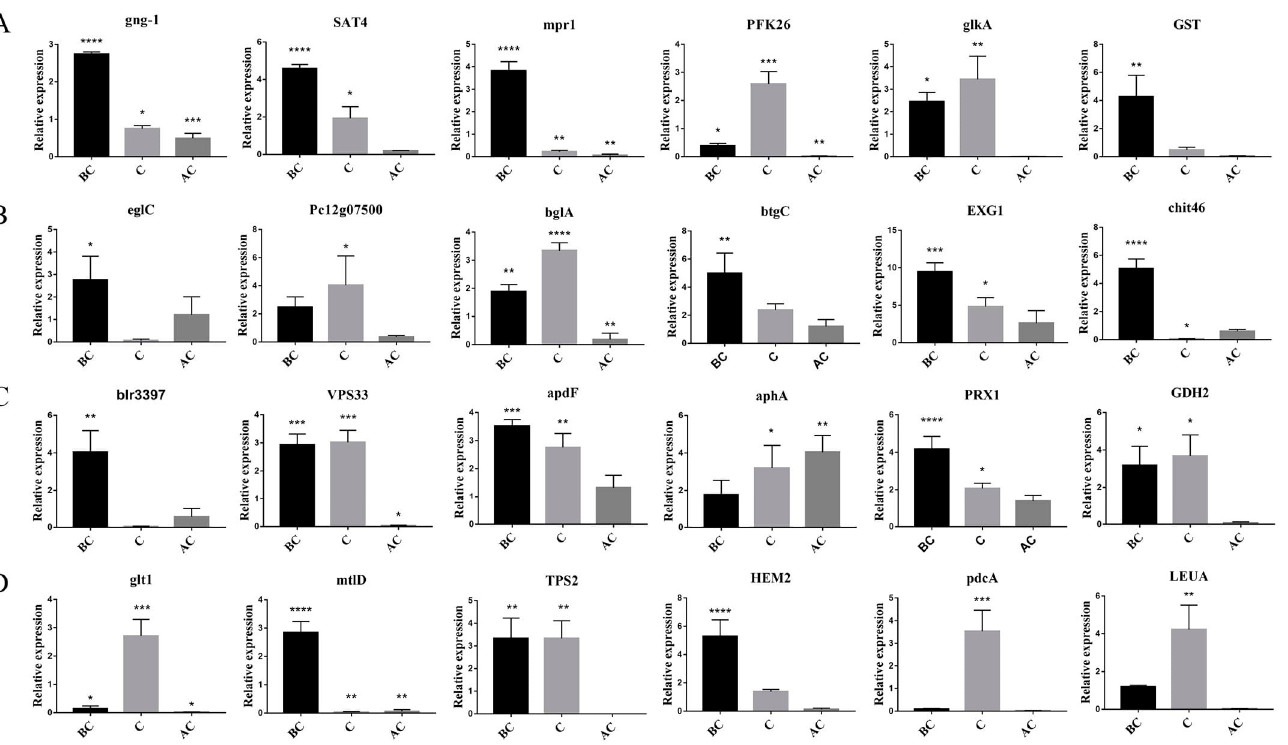
Figure 8. Differential expression and quantitative analysis of 24 genes related to mycoparasitism from the dual-culture direct confrontation experiment. BC: before contact, C: contact, AC: after con- tact. ( A ) Expression analysis of guanine nucleotide-binding protein gamma subunit 1, HAL protein kinase, phosphorelay intermediate protein, 6-phosphofructo-2-kinase, hexokinase and glutathione S-transferase. ( B ) Expression analysis of glucan endo-1,3-beta-glucosidase, murein transglycosylase, beta-glucosidase, glucan endo-1,3-beta-glucosidase, exo-beta-1,3-glucanase and endochitinase. ( C ) Expression analysis of nitrilase, lysine-specific histone demethylase 1, peptide chain release factor 1, acid phosphatase, peroxidase and lutamate/leucine/phenylalanine/valine dehydrogenase. ( D ) Ex- pression analysis of glutamate synthase precursor, mannitol-1-phosphate dehydrogenase, trehalose 6-phosphate synthase, delta-aminolevulinic acid dehydratase, pyruvate decarboxylase and leucine- 2. * p < 0.05, ** p < 0.01, *** p < 0.001, **** p < 0.0001.